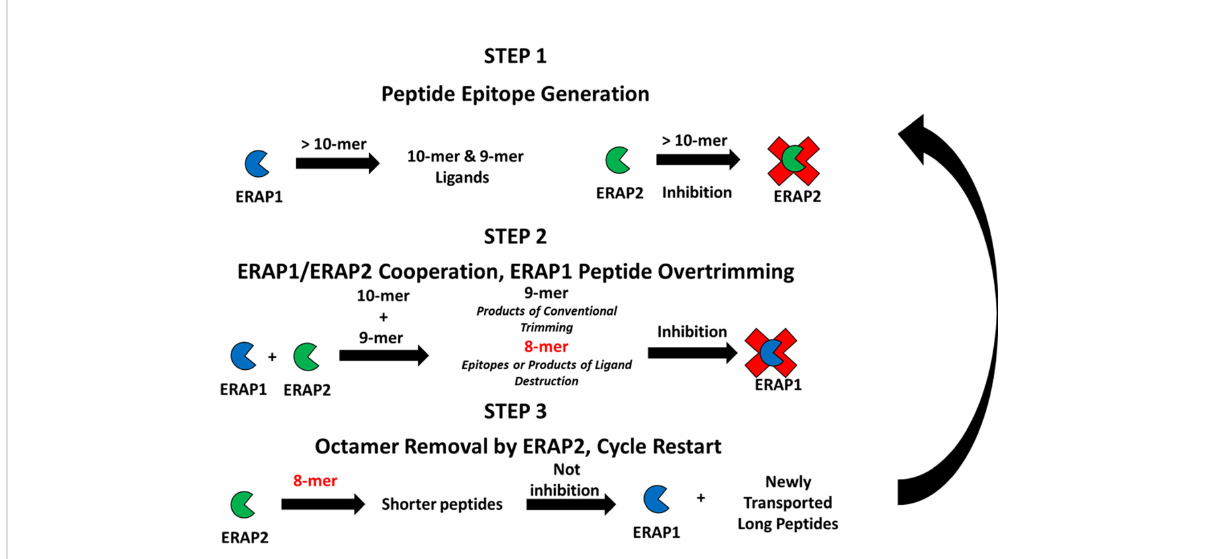
FIGURE 5 Proposed cross-feedback modulation model of ERAP1 and ERAP2 peptide trimming ERAP1 trims long peptides transported into the ER, long peptides may bind unproductively to inhibit ERAP2 activity against newly generated shorter peptide substrates. ERAP1 and ERAP2 cooperate to produce peptides of ideal length for antigen processing. ERAP2 can rescue ERAP1 octamer-dependent inhibition resulting from the overtrimming of epitopes by the combined activities of ERAP1 and